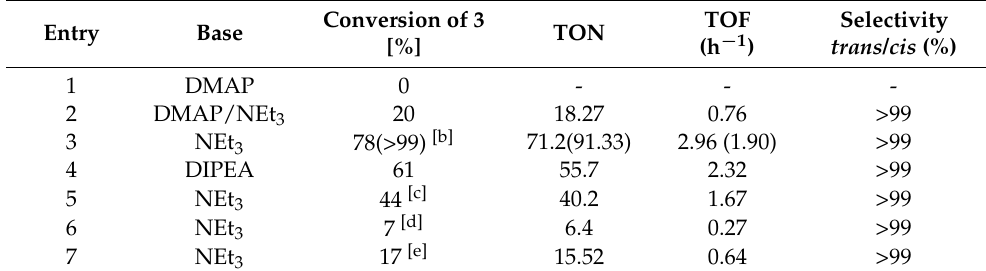
Table 1. Heck coupling of iodobenzene with ethyl acrylate catalyzed by GTL σ -A193Cp-PdNPs bionanohybrid [a]